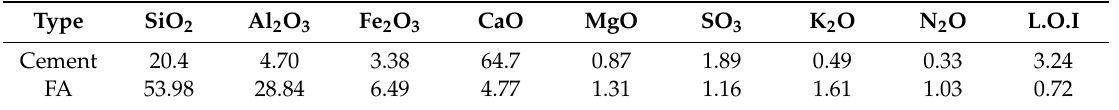
Table 1. Chemical composition of cement and fly ash (mass